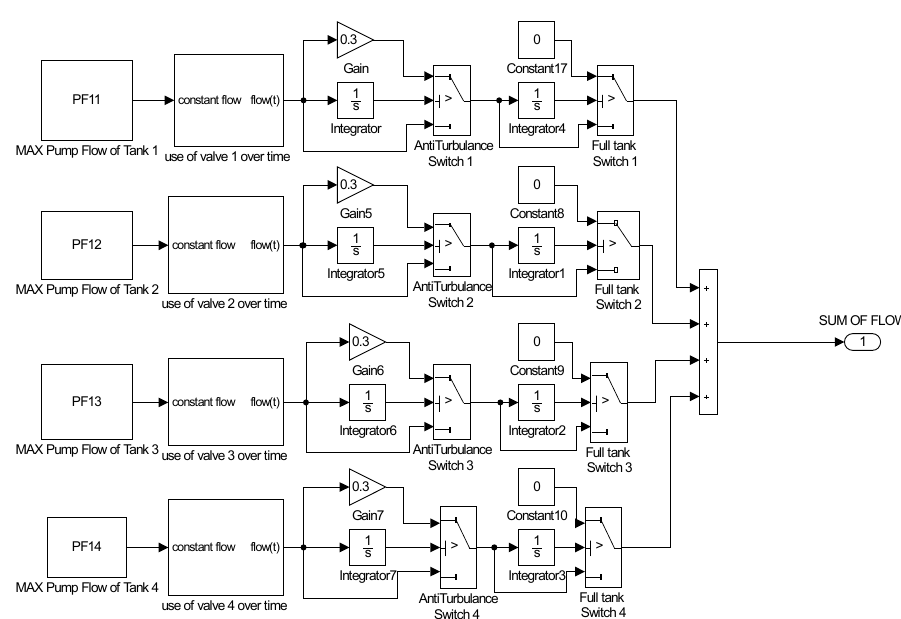
Figure 4. LNGC subsystem modeled in Simulink.